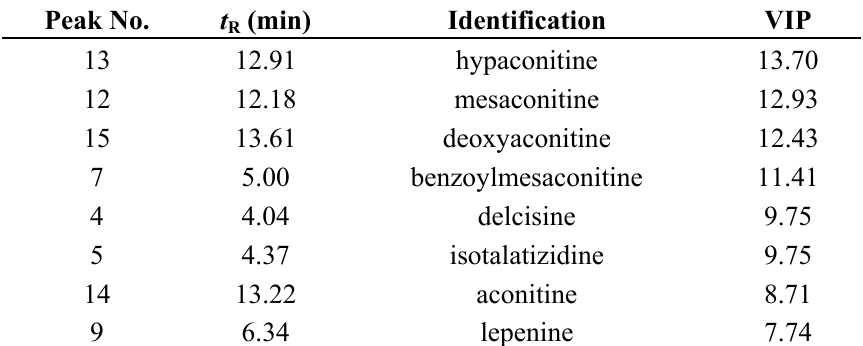
Table 2. First eight discriminatory alkaloid markers in RAK and RAKF. Peak No. t R